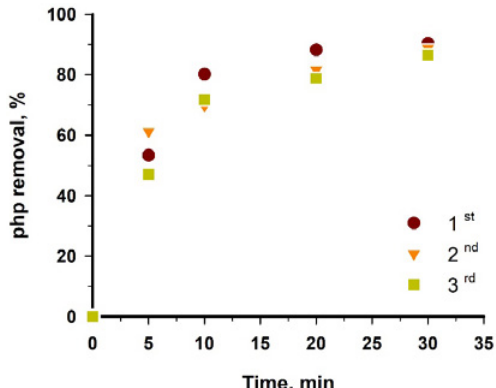
Fig. 9. Reusability of 0.1Fe-ZSM-5 nanocatalyst for PHP removal. Reaction conditions: pH=7, applied current of 100 mA, ultrasonic power of 600 WL -1